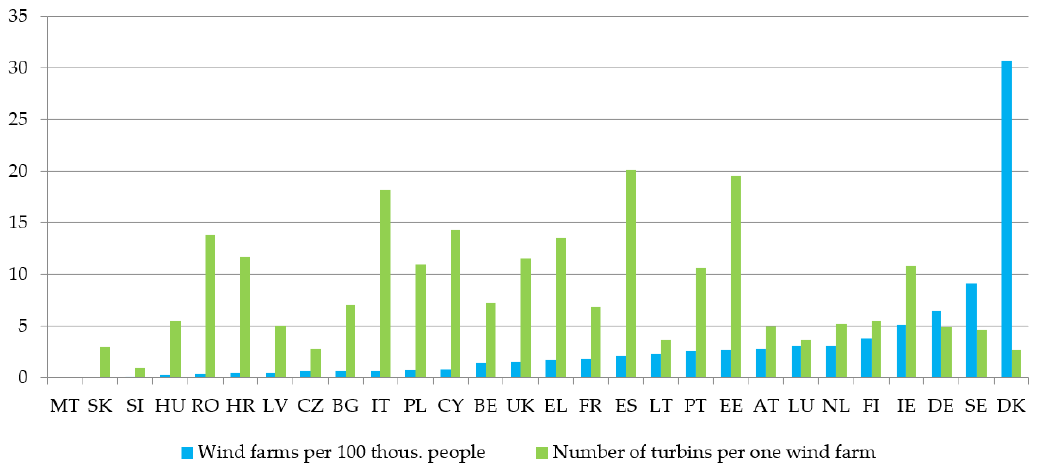
Figure 1. Wind farms per 100 thous. people and the number of turbines per wind farm.